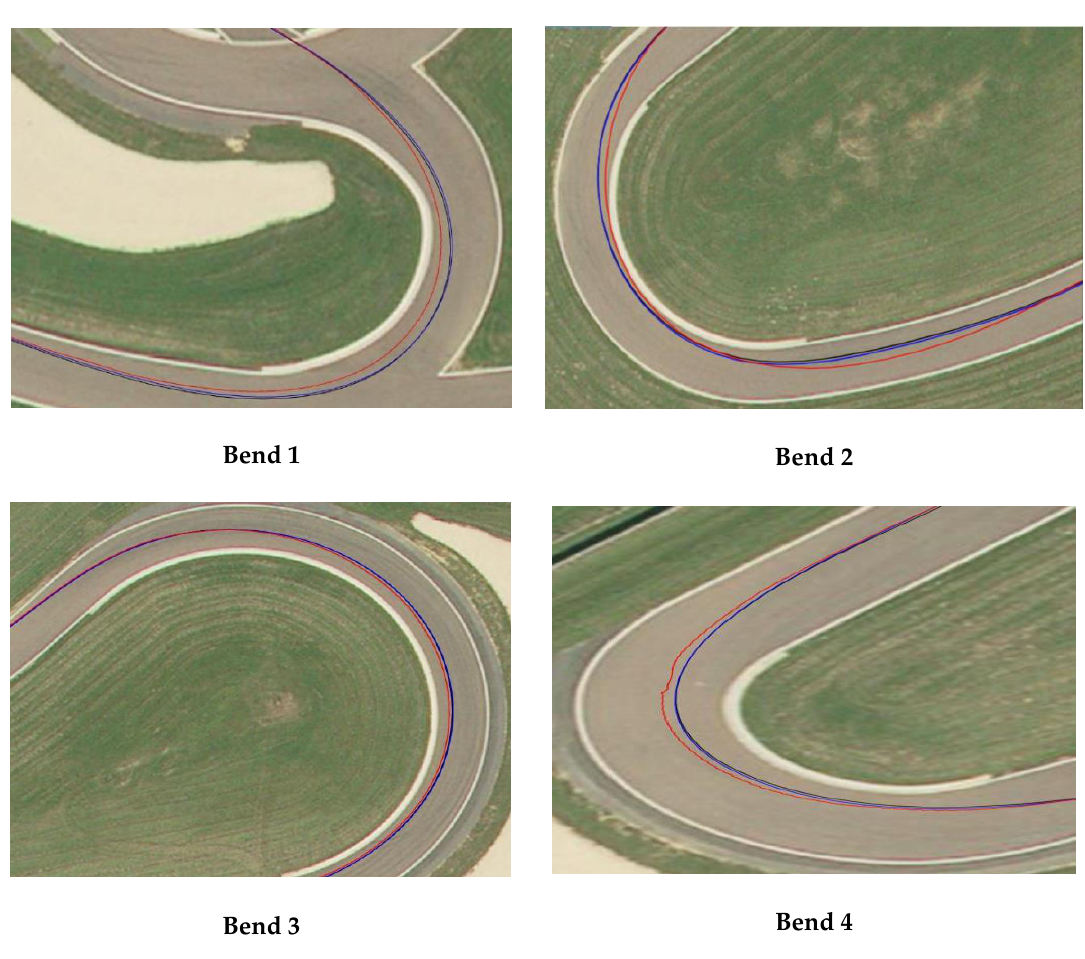
Figure 16. Comparison between the reference trajectory (black curve), GPS/ INS solution (red curve), and the proposed method (blue curve) in the four bends (Bend 1 to 4) showed in Figure